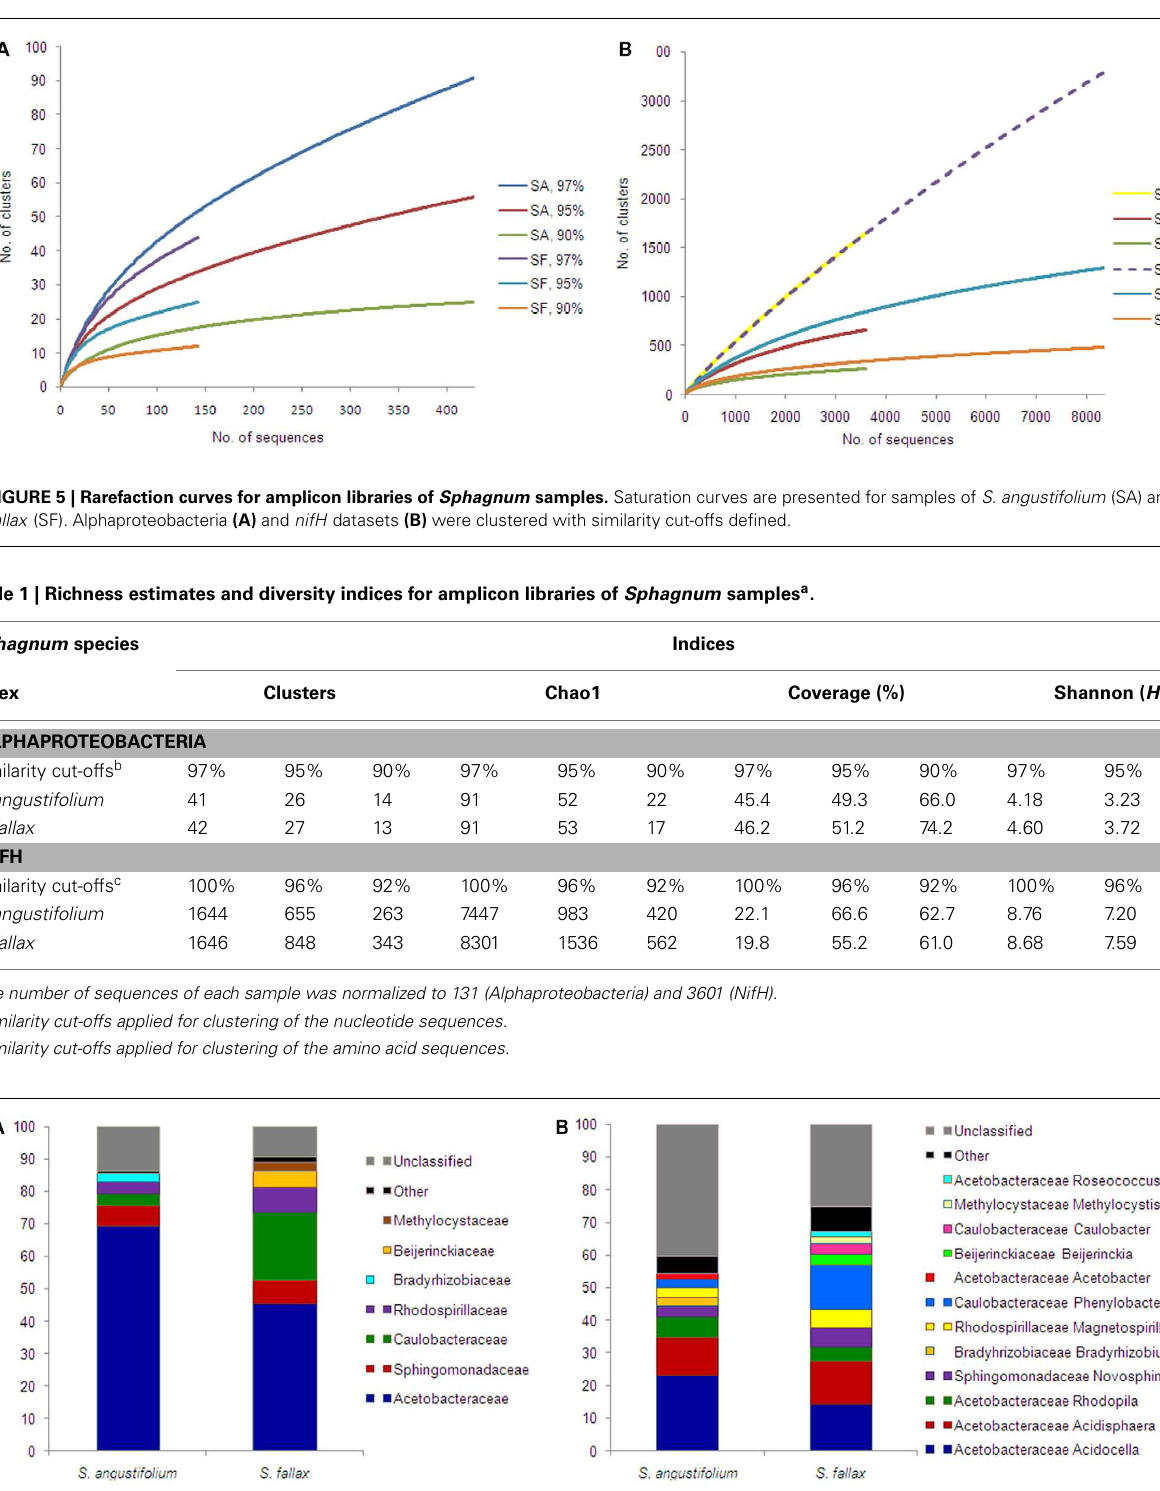
FIGURE 6 |Taxonomic classification ofAlphaproteobacteria associated with S. angustifolium and S. fallax . Pyrosequencing reads are classified at family (A) and genus level (B) with a confidence threshold of 80%. Groups below 1% of relative abundance are included in Other . Multi-colored charts at the legend are shown for each sample